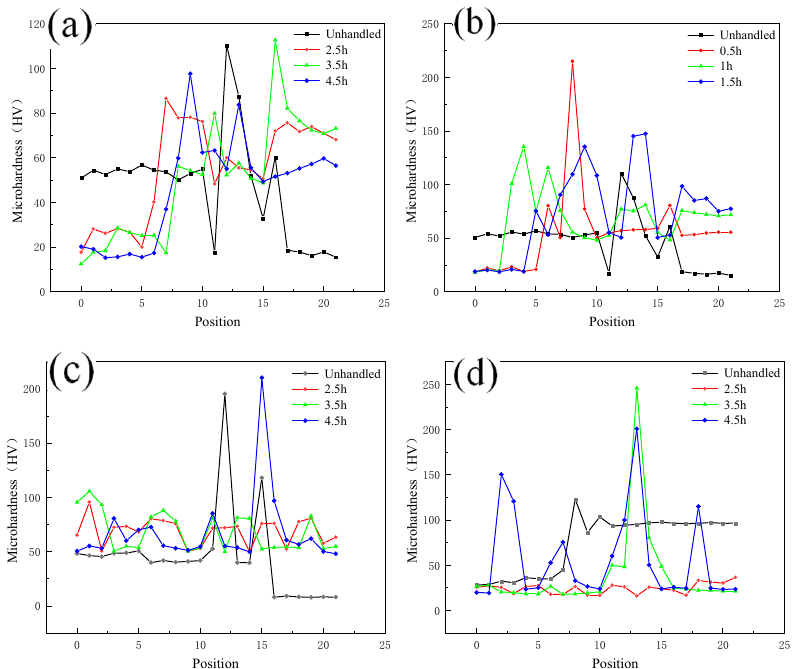
Figure 10. Microhardness of each zone at different annealing temperatures: ( a ) Hardness of nugget zone annealed at 400 °C; ( b ) Hardness of nugget zone annealed at 300 °C; ( c ) Hardness of copper side annealed at 300 °C; ( d ) Hardness of aluminum side annealed at 300 °C.